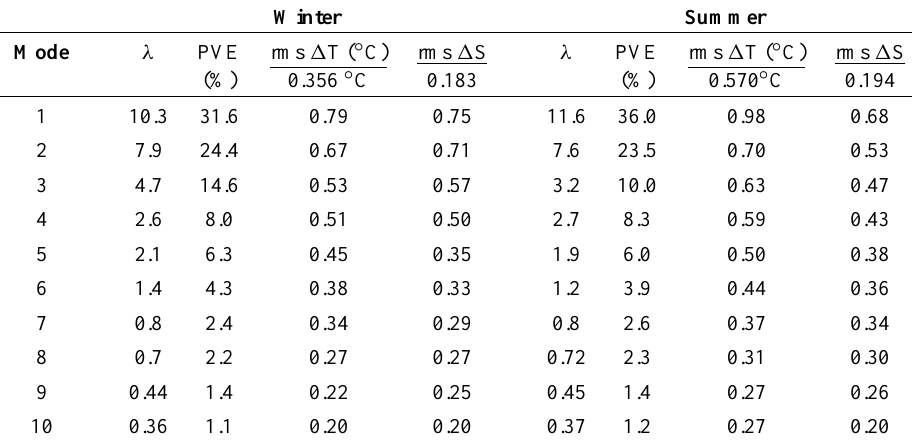
Table 3. The first ten eigenvalues of the covariance matrix of the insitu data in region 2 for winter and summer. The first column contains the eigenvalues. The percentage of the variance explained (PVE, Eq. (3) is shown in the second column. In the remaining two columns for each season, the ratio of the vertical average of the root mean square residual (7b) to the vertically averaged standard deviation (7a) is also shown. This latter is shown only for the layer between 0 and 200m